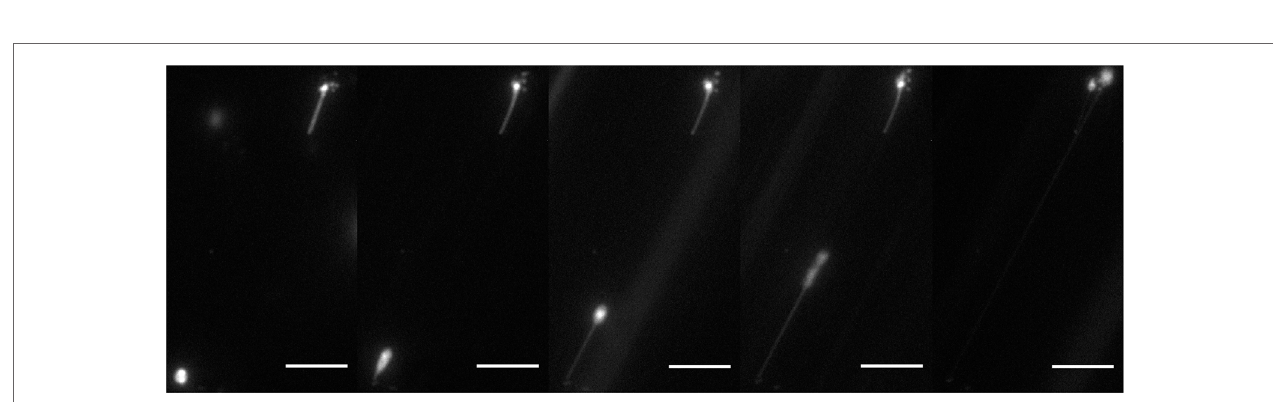
FigUre 3 | Fluorescence microscopy of gUV retraction under high flow . A DOPC/DGS-NTA (5 mol%) GUV of 3 μ m in diameter was being stretched by the flow with an anchor. The GUV stretched into an ellipsoid and retracted back into GUV. Scale bar: 5 μ m.